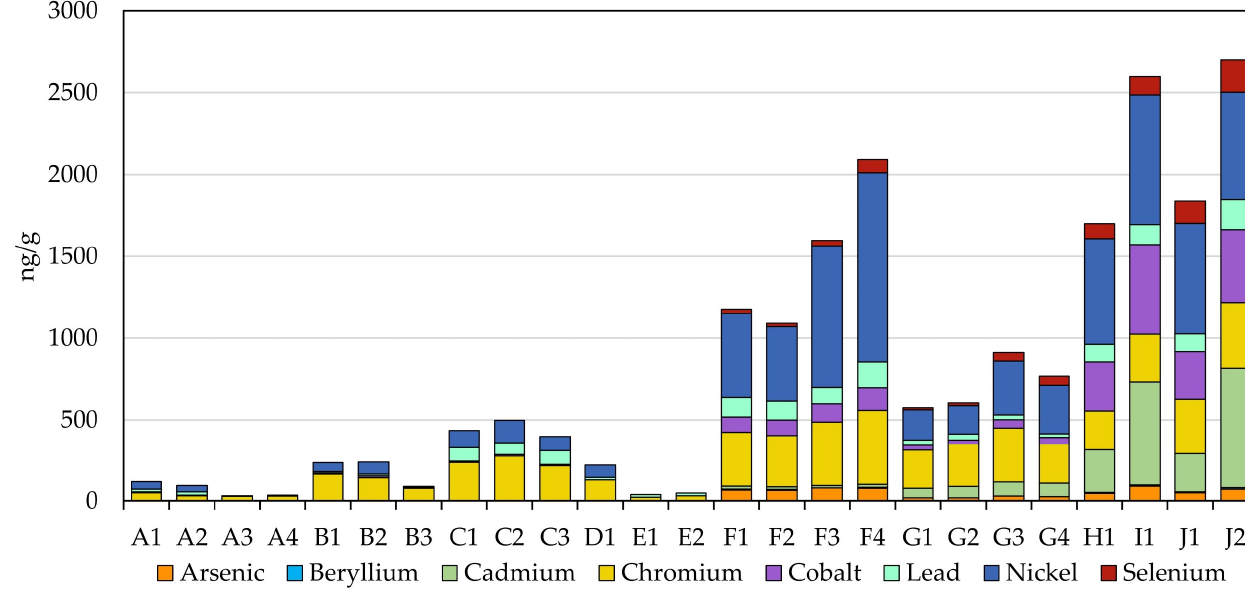
Figure 3. Observed levels of metals in the MONPs and four STPs.